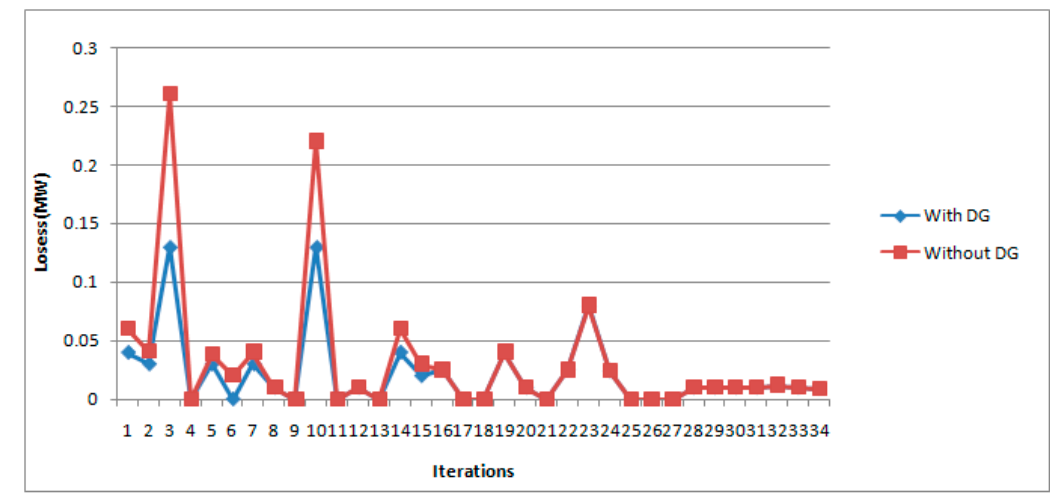
Figure 5. Line losses of 34 bar system with and without DG.